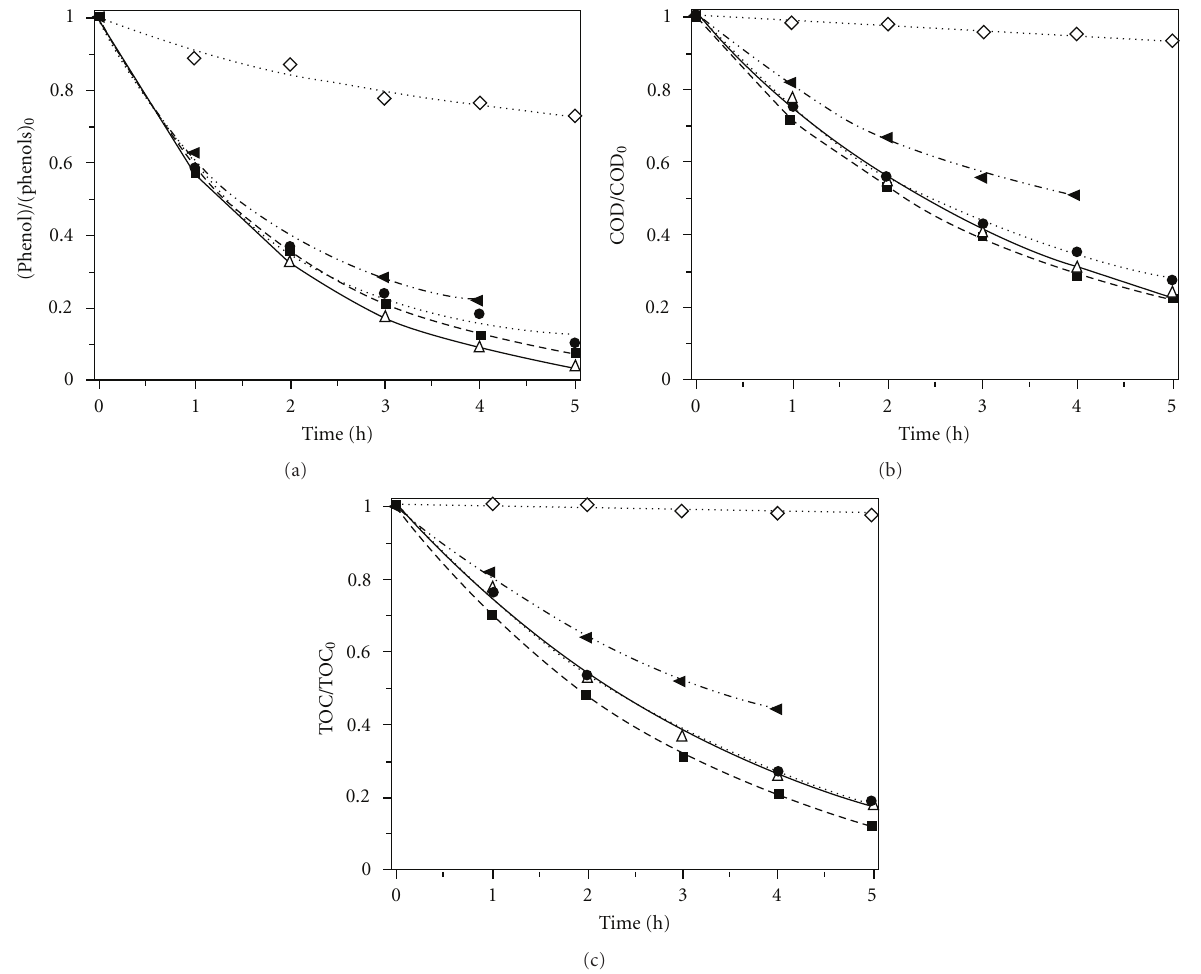
Figure 16: E ff ect of the electrodic material and pH on the electrooxidation of the synthetic tannery wastewater in 0.10 molL − 1 Na 2 SO 4 at 25mAcm − 2 : (a) (phenols)/(phenols) 0 , (b) COD/COD 0 , and (c) TOC/TOC 0 as a function of electrolysis time. Electrolysis conditions: ( ♦ ) Ti/SnO 2 –Sb–Ir and pH 2.4, ( (cid:6) ) Ti/SnO 2 –Sb and pH 2.4, ( (cid:2) ) Si/BDD and pH 2.4, ( • ) Si/BDD and pH 7.3, and ( (cid:5) ) Si/BDD and pH 12.0